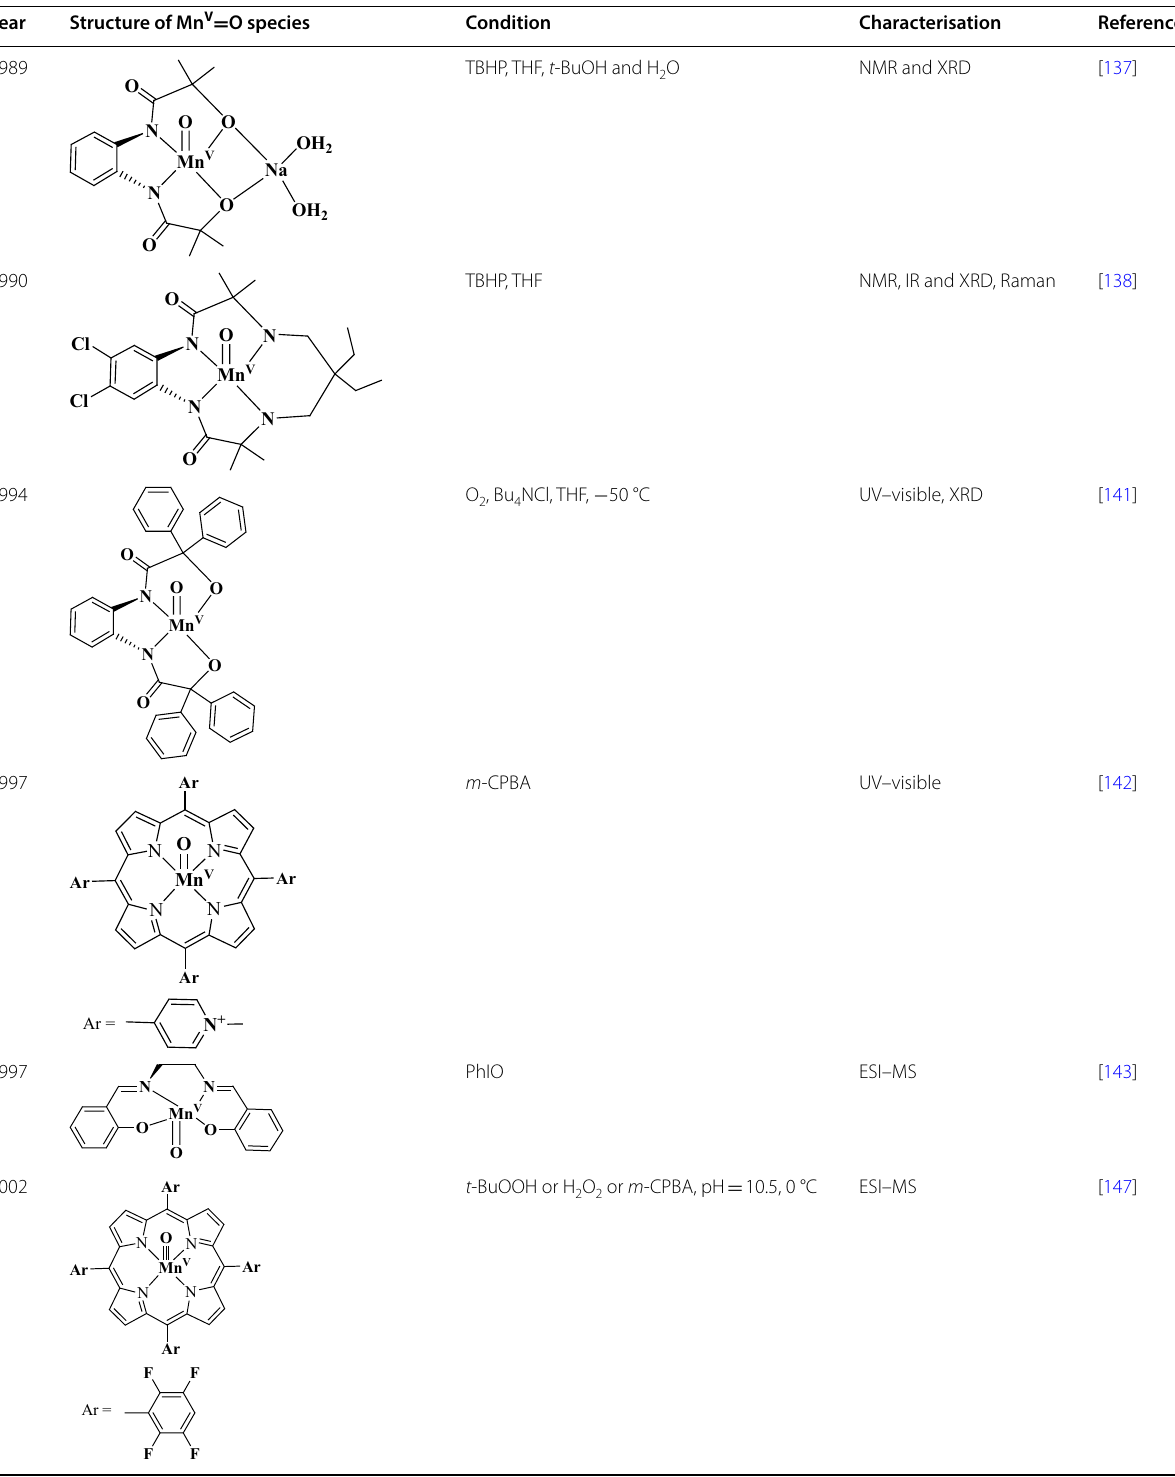
Table 2 List of Mn V Year Structure of Mn V